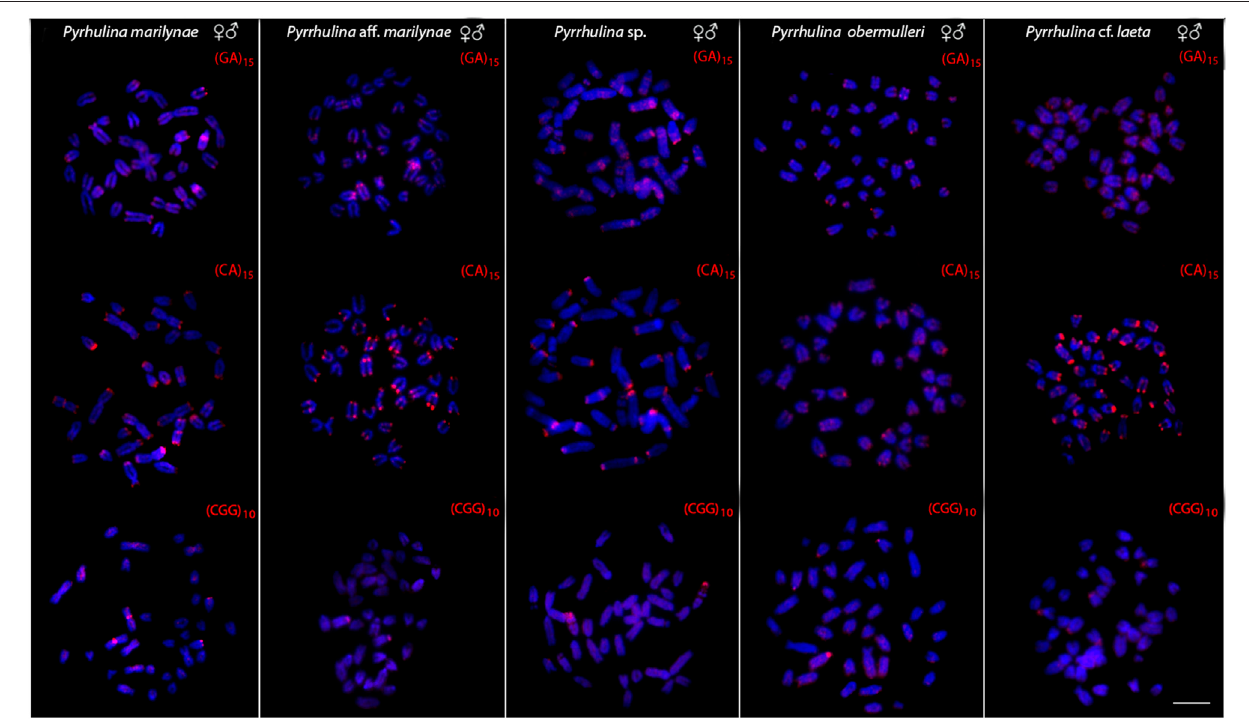
FIGURE 3 | Male and female metaphase plates of Pyrrhulina marilynae ; Pyrrhulina aff. marilynae ; Pyrrhulina sp.; P. obermulleri and Pyrrhulina cf. laeta shows the general distribution of the microsatellites (GA) 15 , (CA) 15 and (CGG) 10 on chromosomes. Bar (cid:1) 5 μ m.